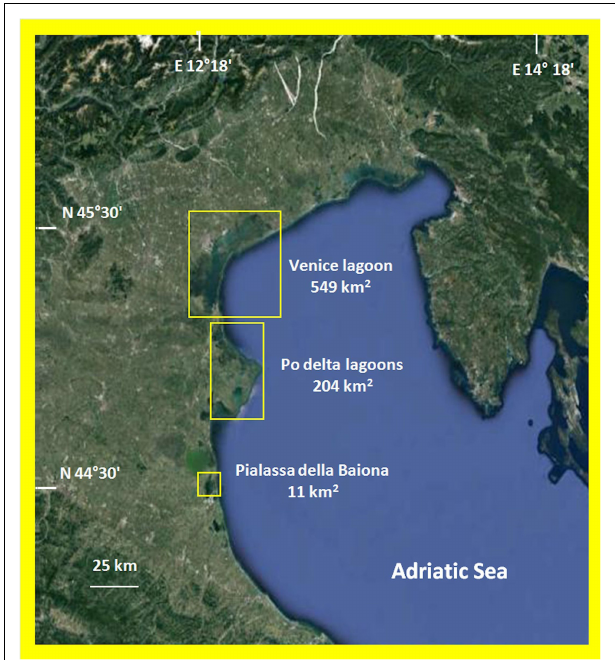
FIGURE 1 | Map of the studied lagoons in North-western Adriatic